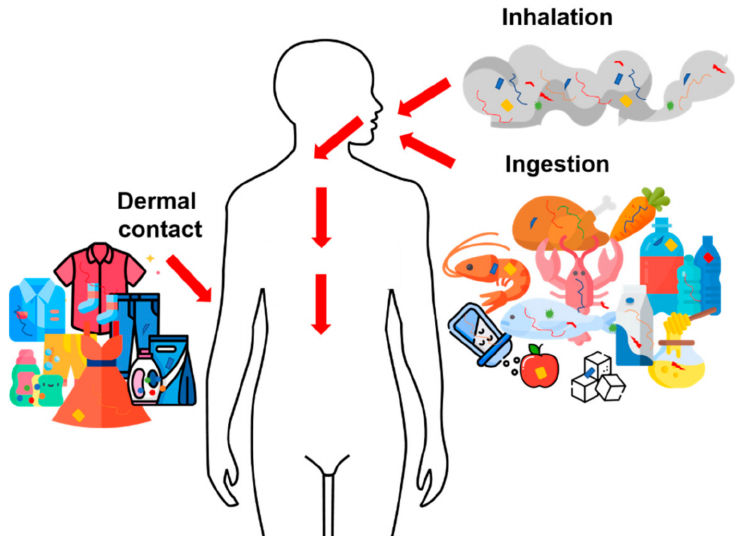
Figure 2. Schematic representation of exposure to microplastics through three routes: ingestion, inhalation, and dermal